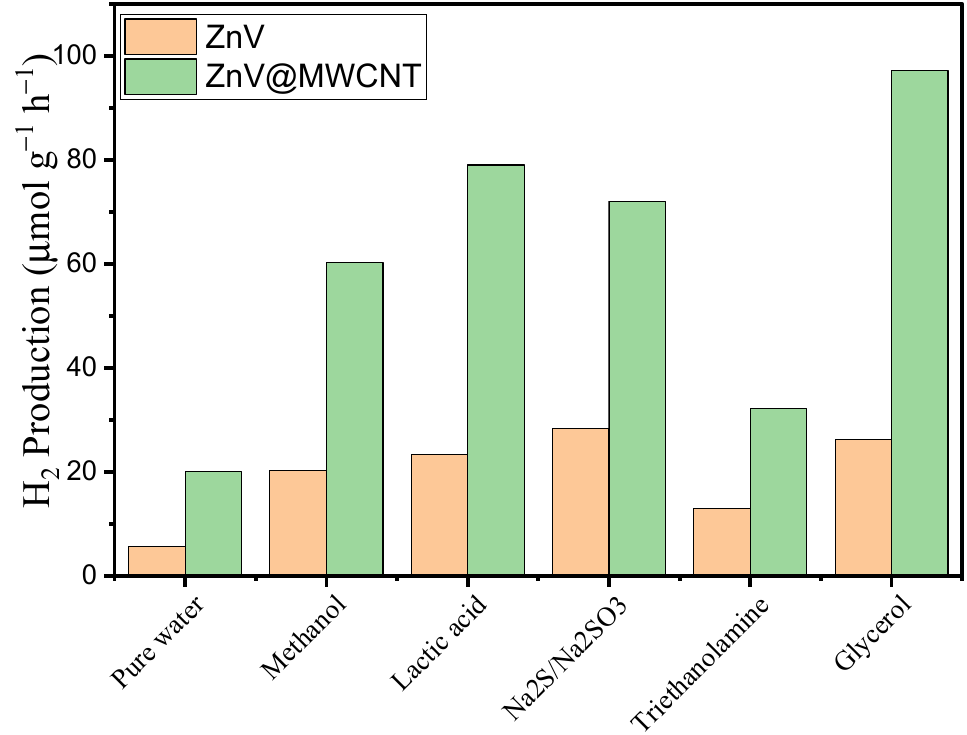
Figure 9. Effects of various sacrificial reagents on ZV and ZV@MWCNT for PC H 2 production reac- Effects of various sacrificial reagents on ZV and ZV@MWCNT for PC H 2 tion. production